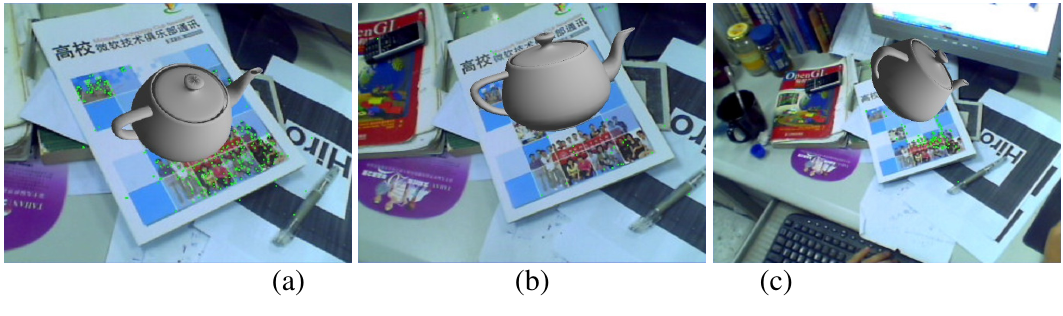
Figure 11. Results of the first experiment used to compare the multiple keyframes based method with two keyframes based